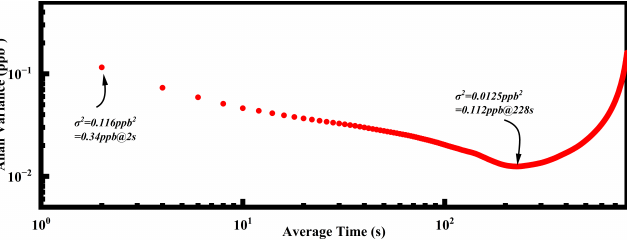
Figure 11. The allan variance of the system.